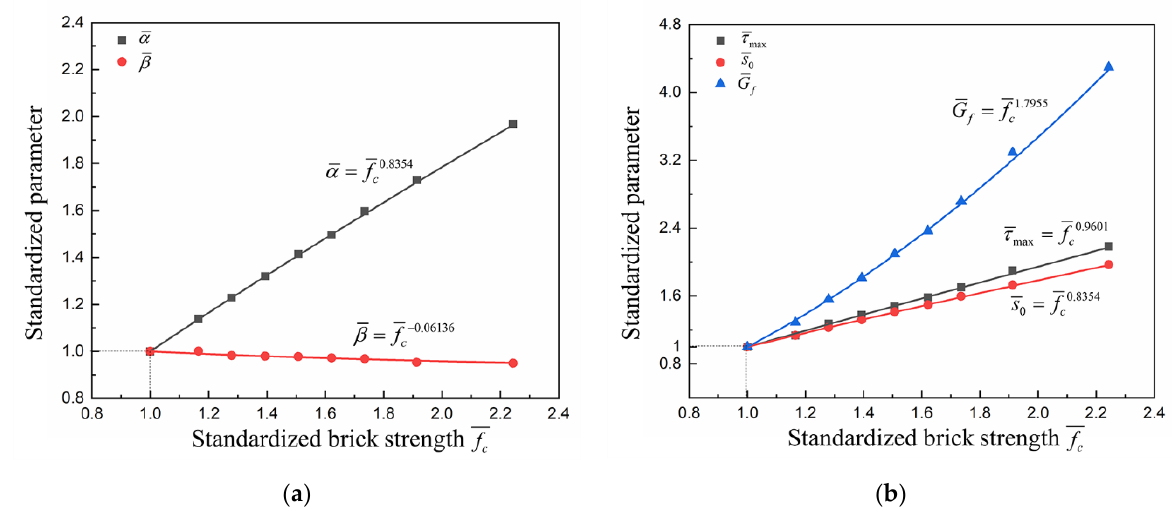
G . Figure 21. The influences of brick strength on bond–slip parameters: ( a ) α and β ; ( b ) τ  , max , s 0 and G f s and f max 0